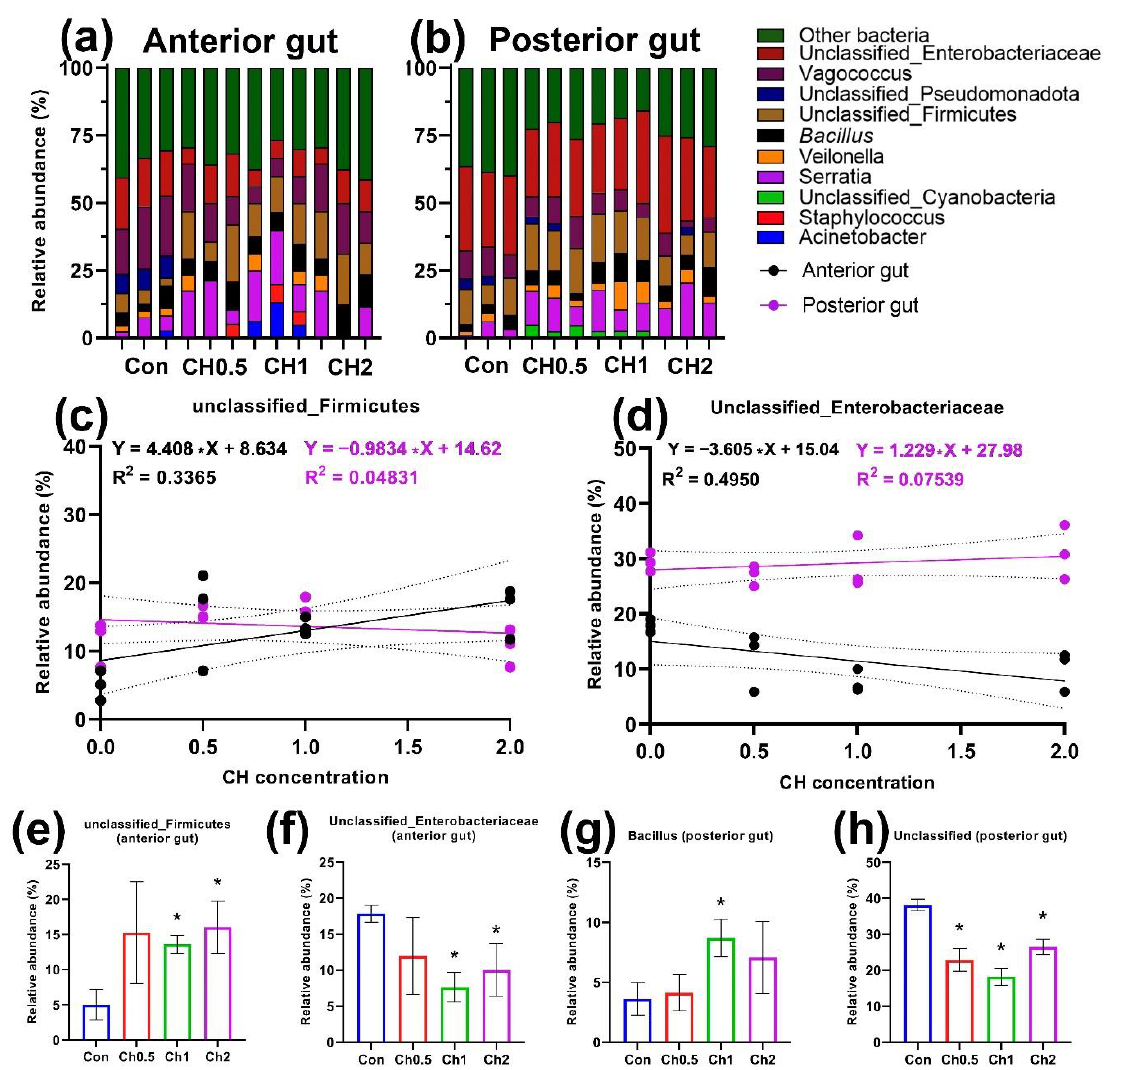
Figure 1. Cultivated microbiota of the anterior and posterior sections of the intestine of the experi- mental groups of D. rerio receiving chelated compounds of trace elements ( n = 3). Unclassified bacterial groups are labeled within defined taxonomic groups: ( a , b ) relative abundance of microbiota by bacterial genus in the anterior and posterior gut sections, respectively; ( c , d ) linear regression of the relative abundance of bacteria from unclassified_ Firmicutes and unclassified_ Enterobacteriaceae groups and CH concentration in the anterior (black dots) and posterior (purple dots) sections; ( e – h ) relative abundance of different bacteria groups in the control and experimental groups. The value (* — p < 0.05) from the Mann – Whitney test.